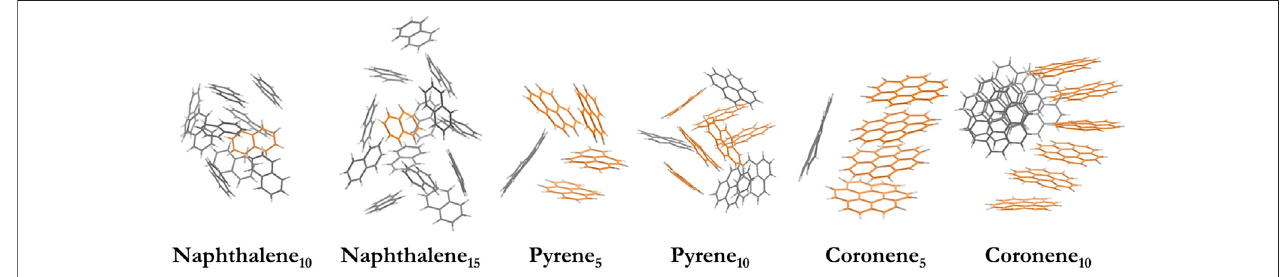
TABLE 1 | The errors in energy barriers of transition states using different frozen schemes and the respective ZPE corrections. a